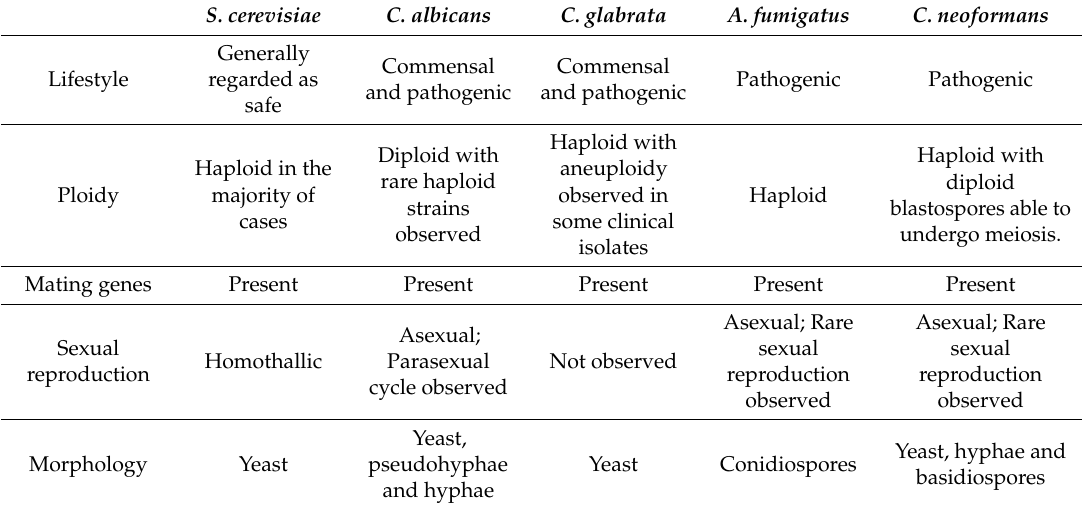
Table 2. Summary of key characteristics of pathogenic